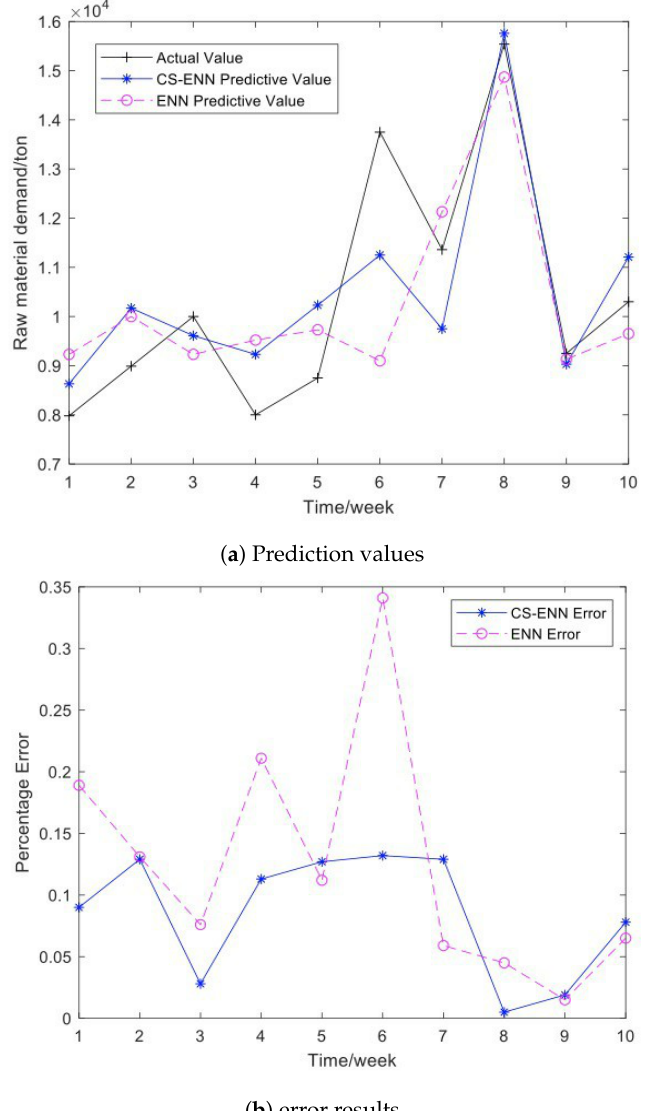
Figure 8. CS-Elman and ENN prediction results.